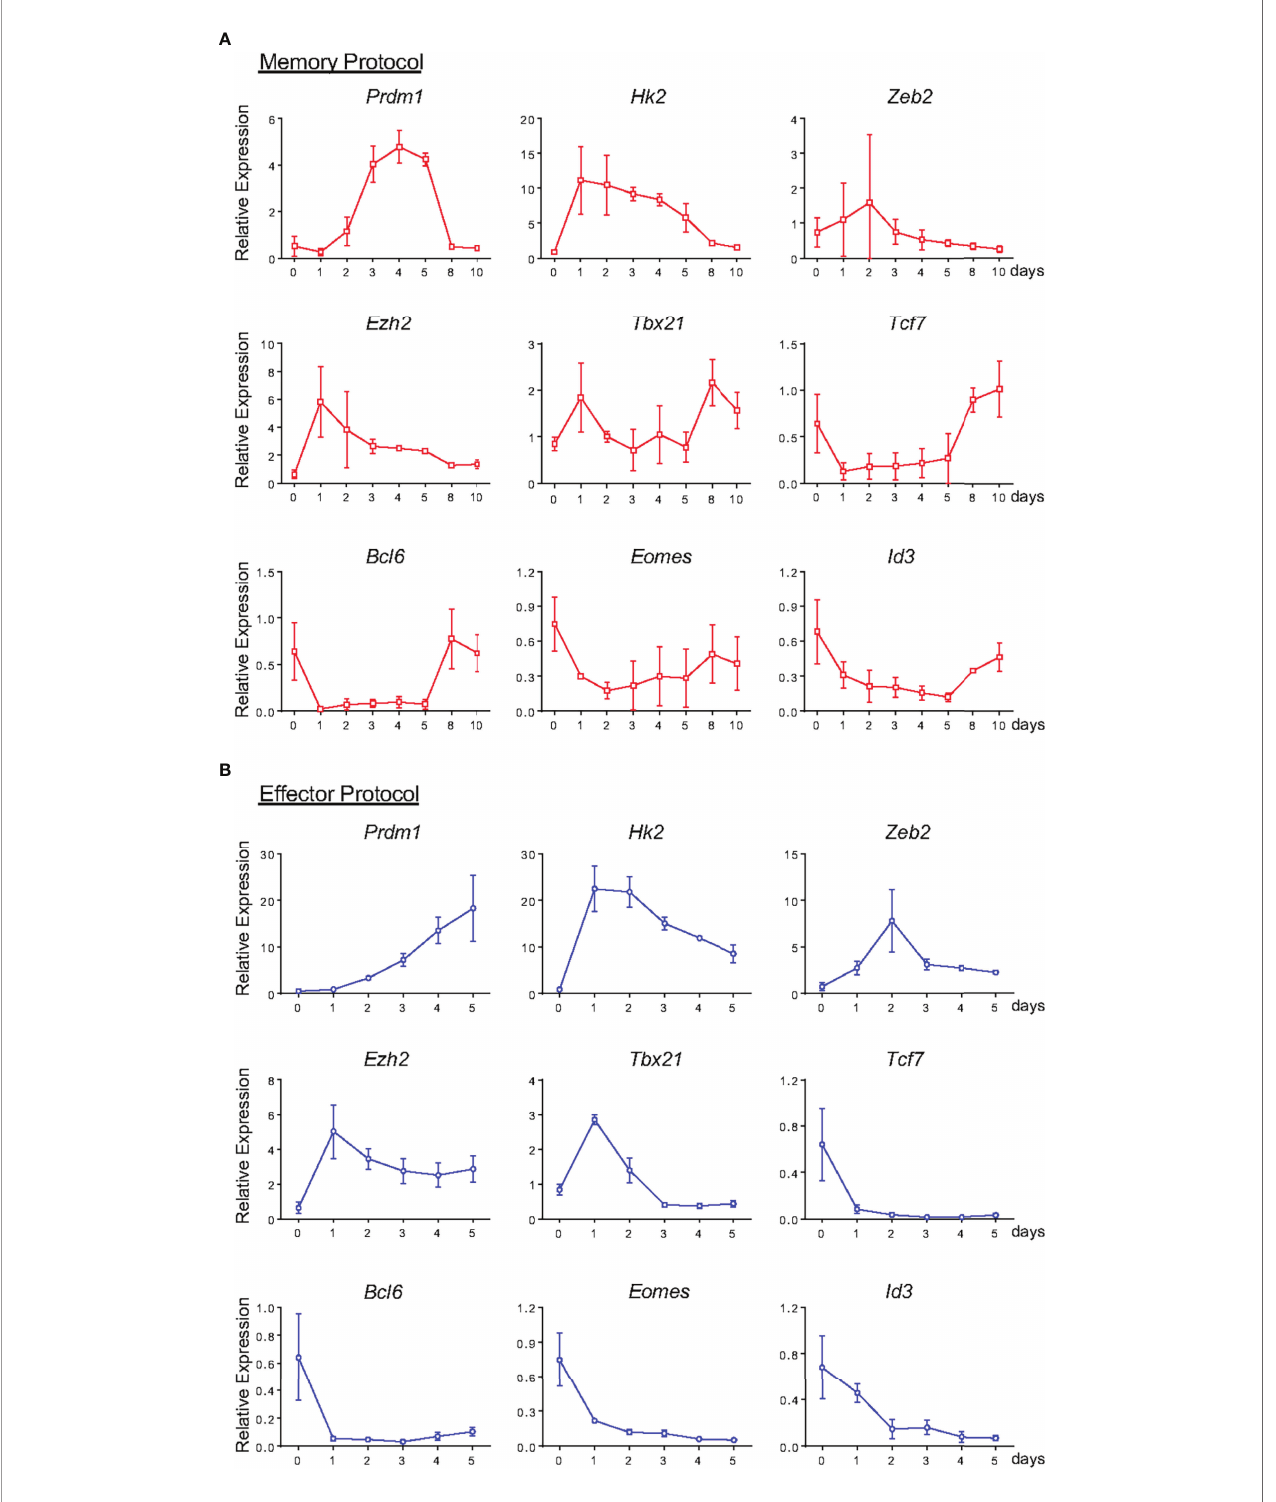
FIGURE 9 | Gene expression pro fi le of Memory and Effector CD8 T cells at Different Stages of In Vitro Differentiation. From Figure 8 , lymphocytes from memory (A) and effector (B) protocol were analyzed by the real-time RT-PCR assay using TaqMan probe for the indicated genes. The data were normalized to the Hprt housekeeping gene, and the reference was the lowest Ct mean obtained from day 0 of differentiation. Bar graphs represent the mean ( ± SD) of RNA expression analysis. All results are representative of 3 independent